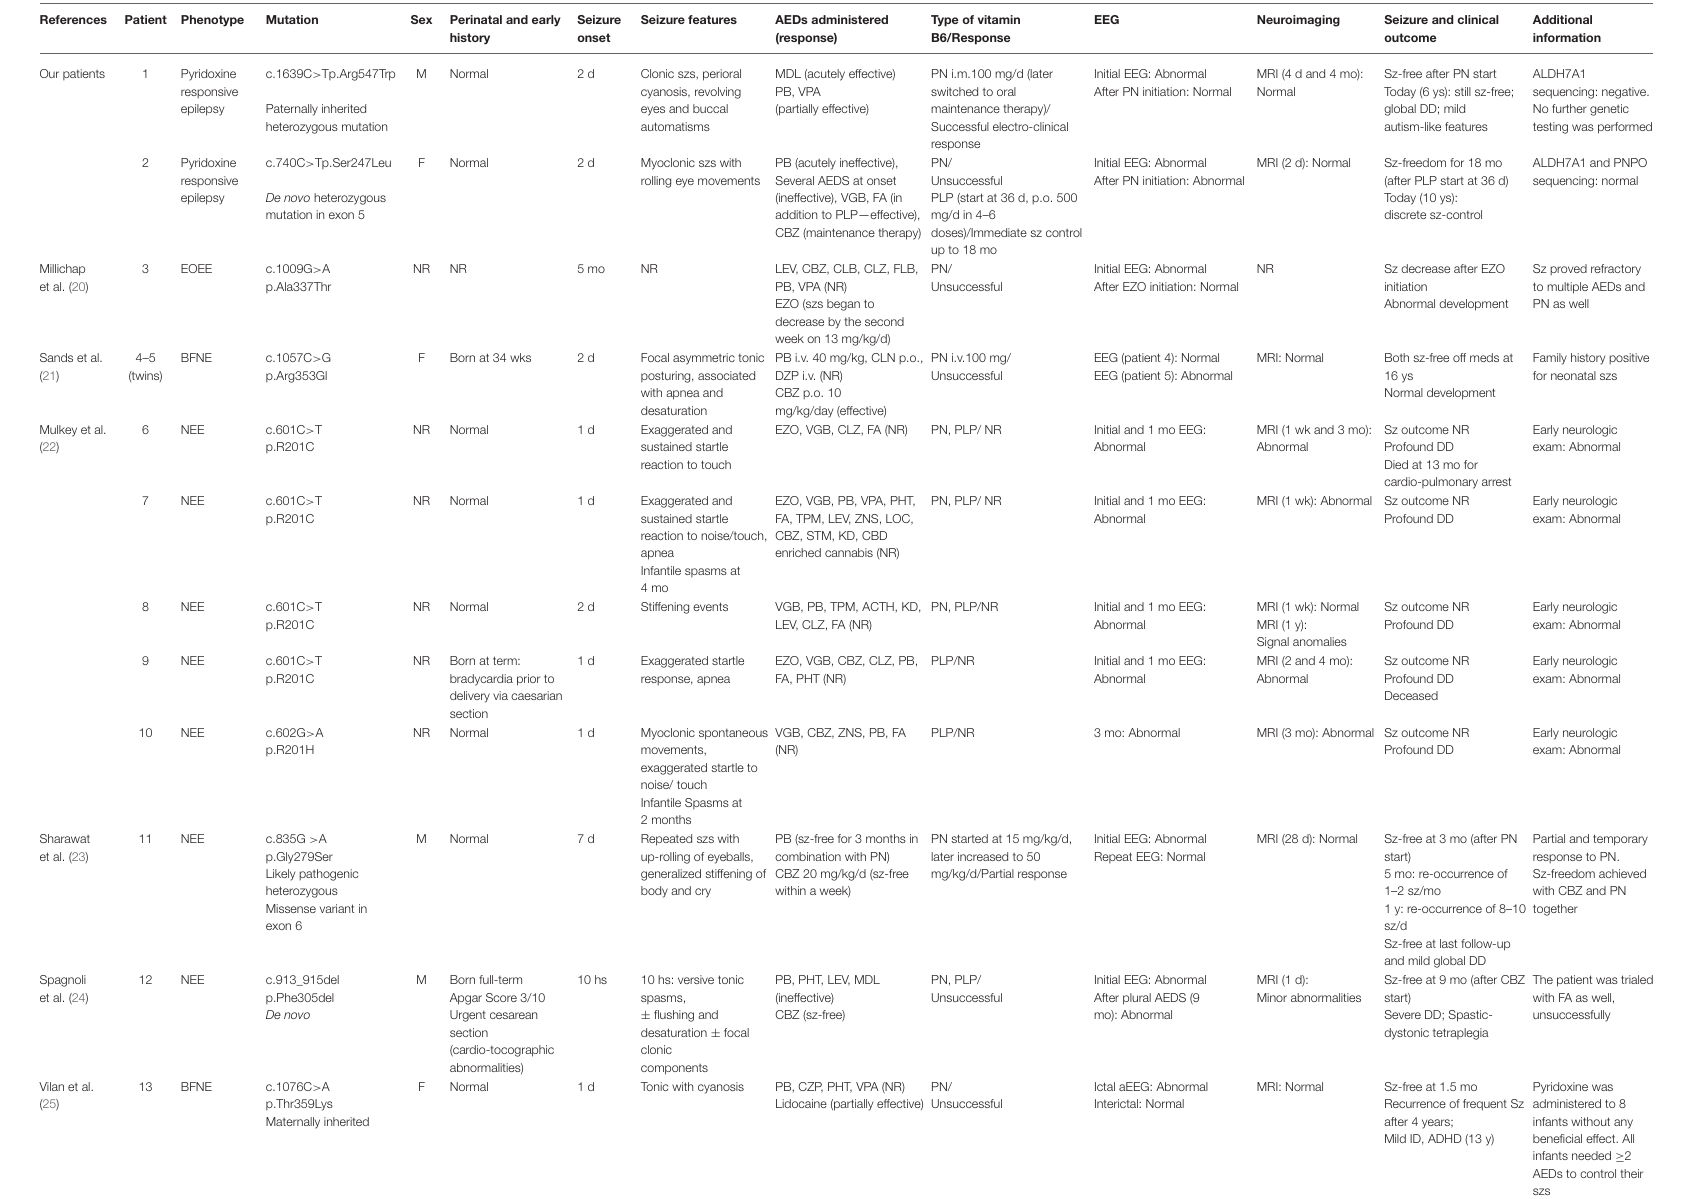
TABLE 1 | Patients described in the literature who carry a KCNQ2 mutation and have been trialed with vitamin B6.